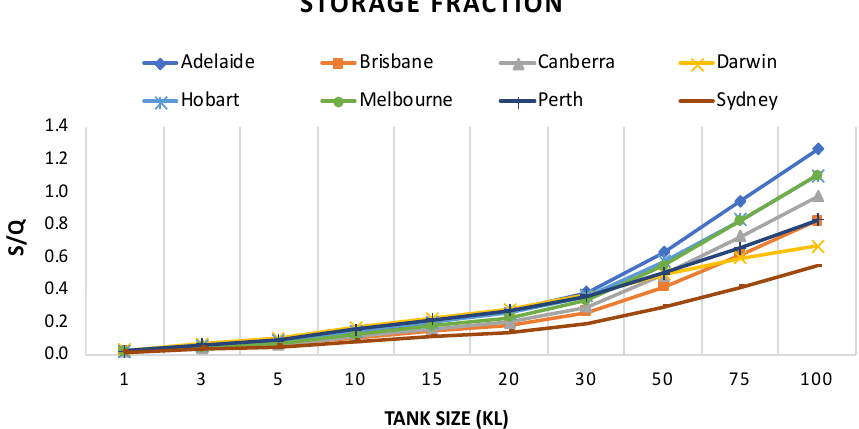
Figure 9. Storage fraction (S/Q) vs. tank size for all eight locations.